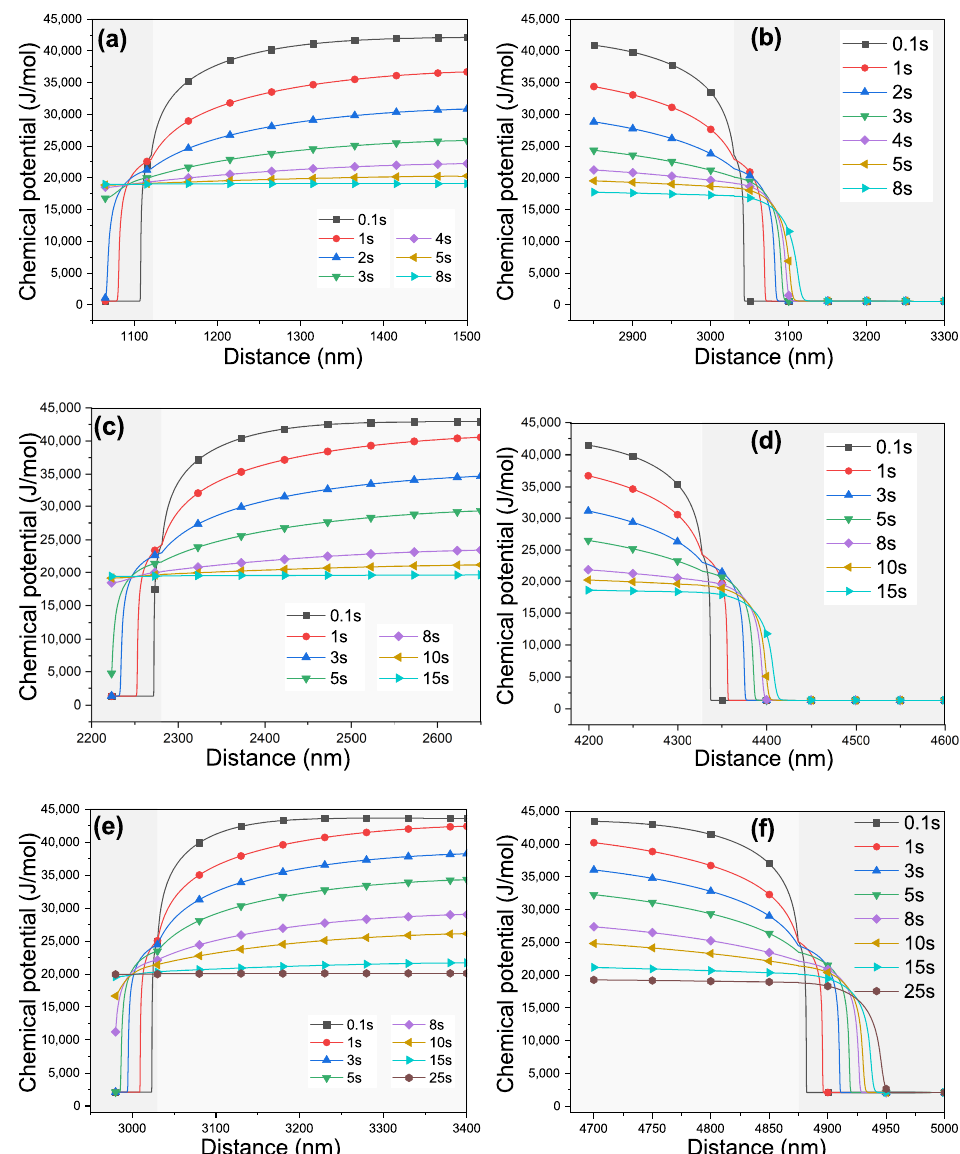
Figure 2. Carbon chemical potential profiles for the partitioning time ranging from 0.1 to 25 s at ( a , b ) 330 ◦ C, ( c , d ) 310 ◦ C, and ( e , f ) 292 ◦ C, between ( a , c , e ) film-like austenite and lath martensite, ( b , d , f ) blocky austenite and lath